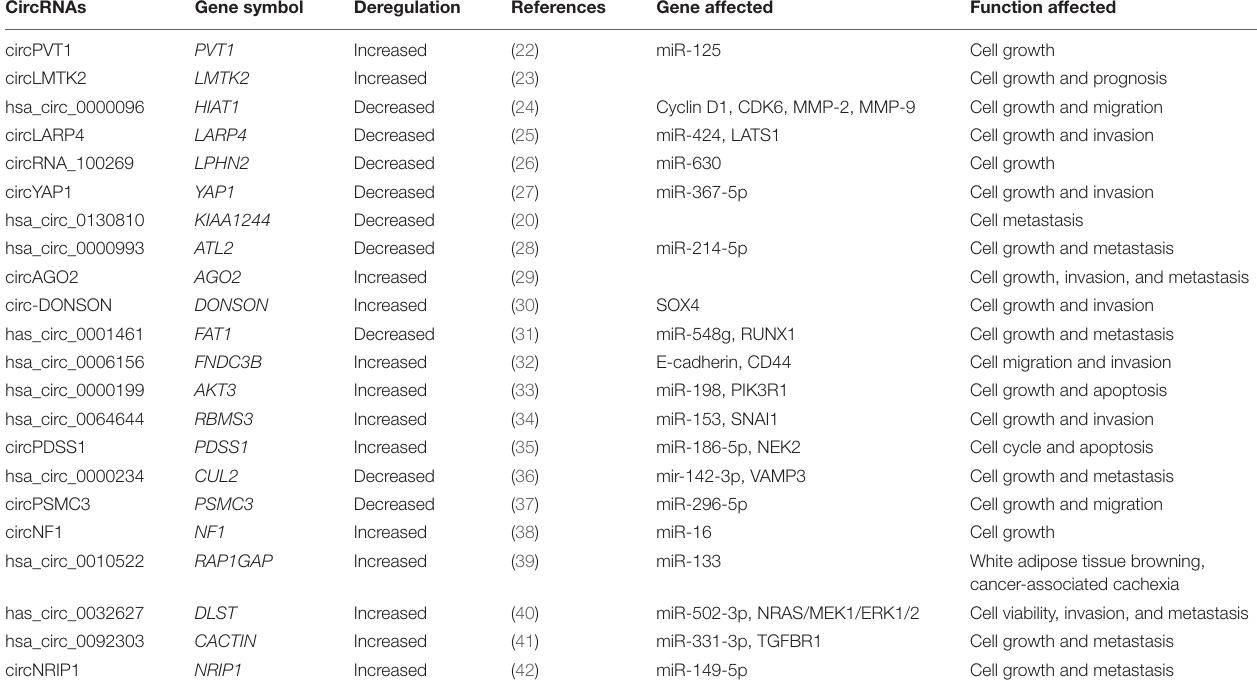
TABLE 1 | Expression of CircRNAs associated with human gastric cancers. CircRNAs Gene